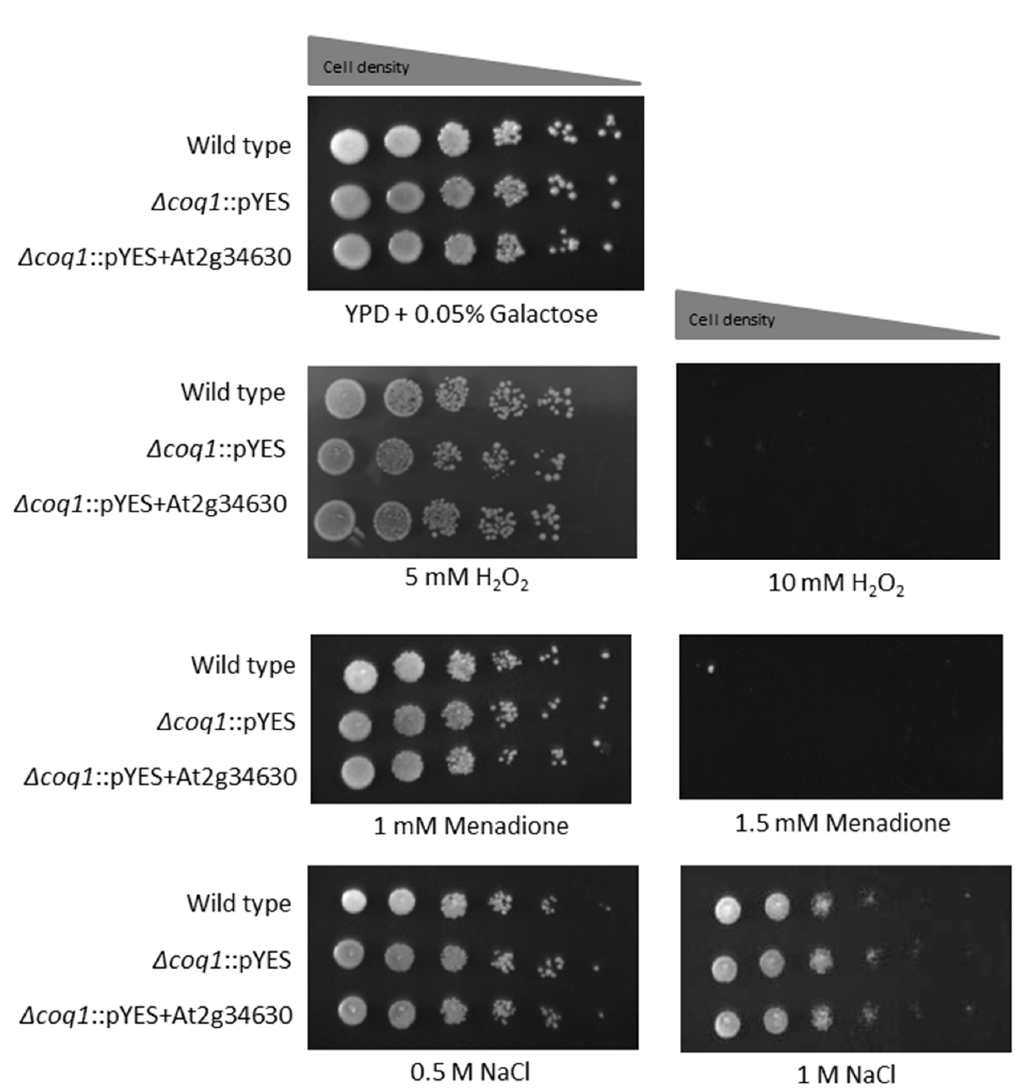
Figure 6. Sensitivities to other stress conditions. Serial 10-fold dilutions of cells were spotted onto YPD +0.05% galactose agar plates containing the indicated salt or oxidant and photographed after 48 h at 30